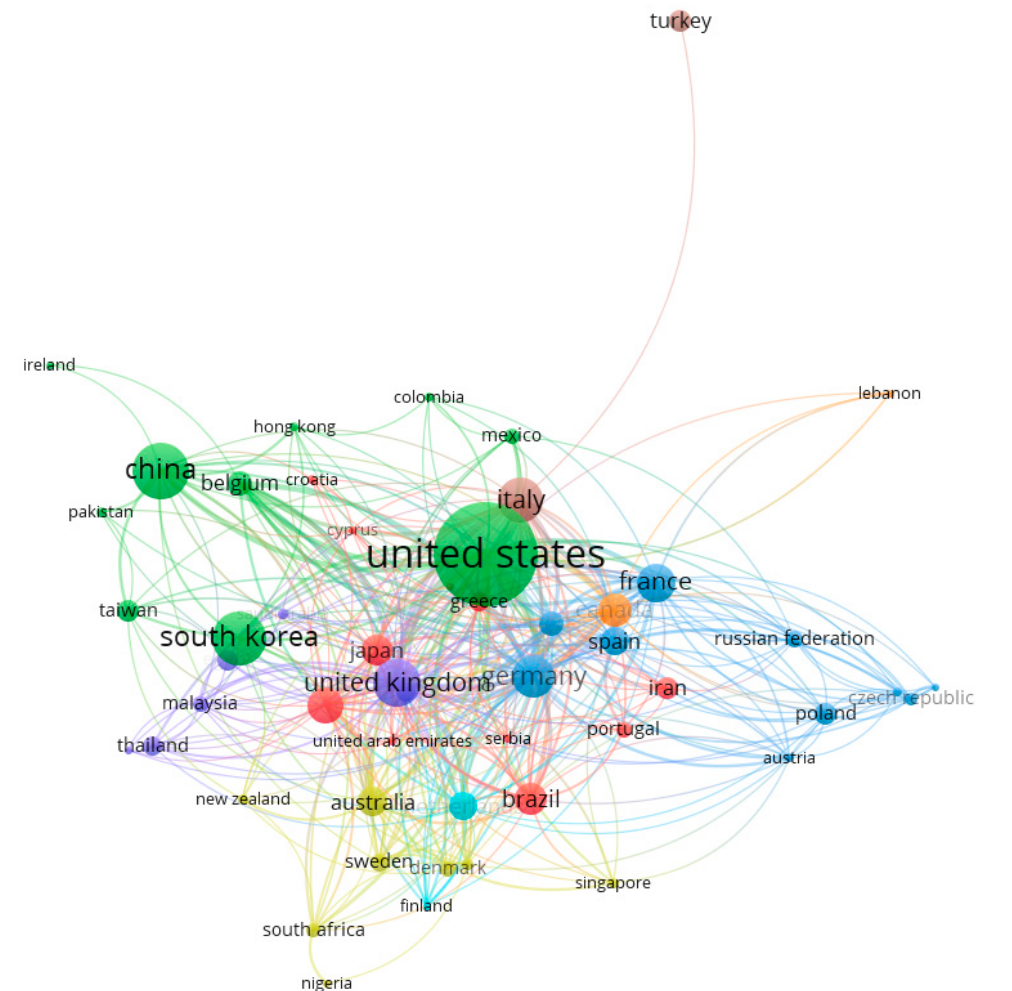
Figure 3. Countries network of literature on the adverse effects of cosmetics.